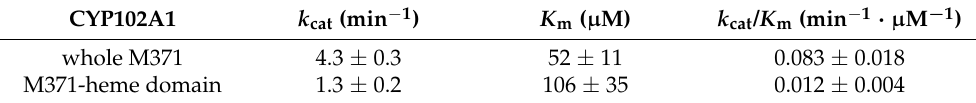
Table 1. Kinetic parameters of atorvastatin 4-hydroxylation by whole M371 and M371-heme